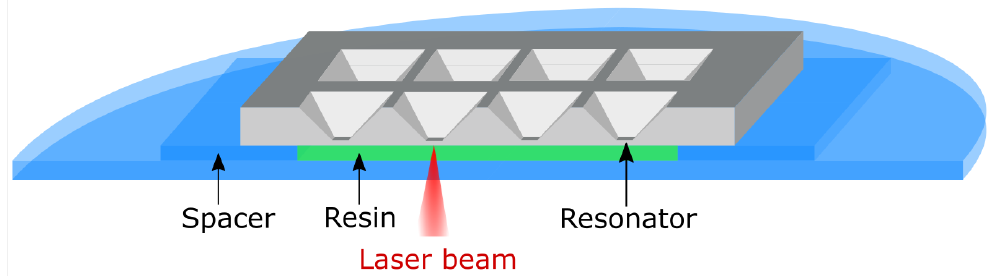
Figure 3. Assembly for direct laser writing (DLW). The chips (grey) were placed on a cover glass (blue) covered with a drop of resin solution (green), separated by glass cutouts. Illumination was done upside down through an oil immersion objective by the laser (red).